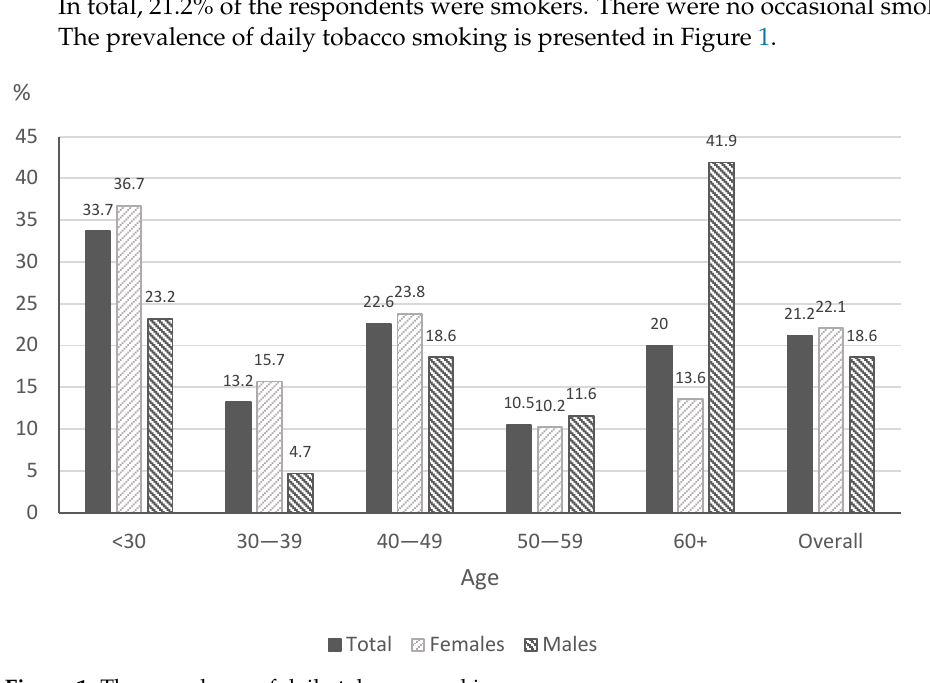
Figure 1. The prevalence of daily tobacco smoking.